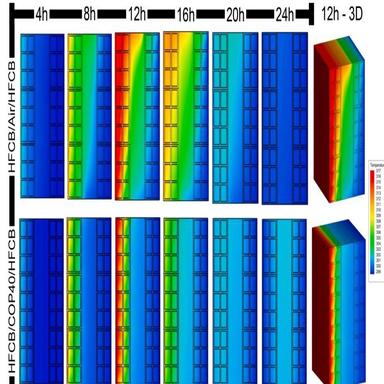
Temperature distribution in the two systems HFCB/AG/HFCB and HFCB/COP40/HFCB for different times during the day.